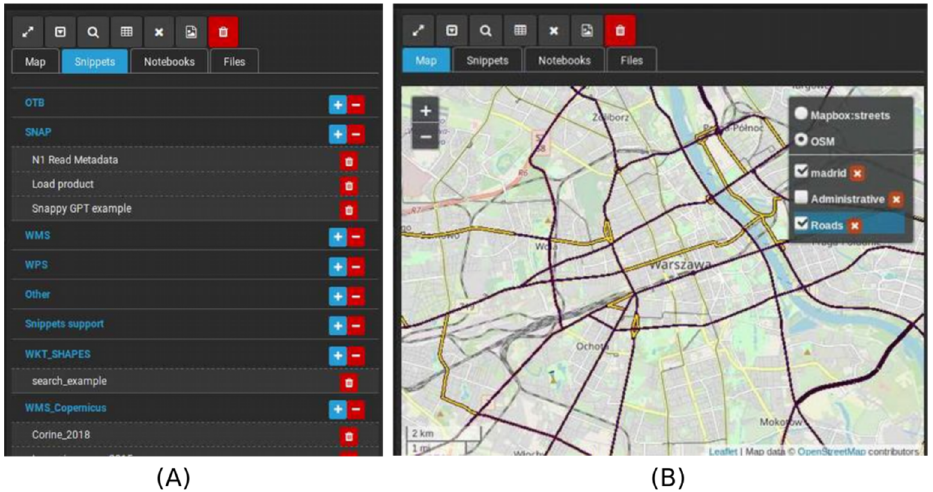
Figure 13. Side panel—( A ) tab Snippets view, ( B ) tab Map view with web map service (WMS) layers added.